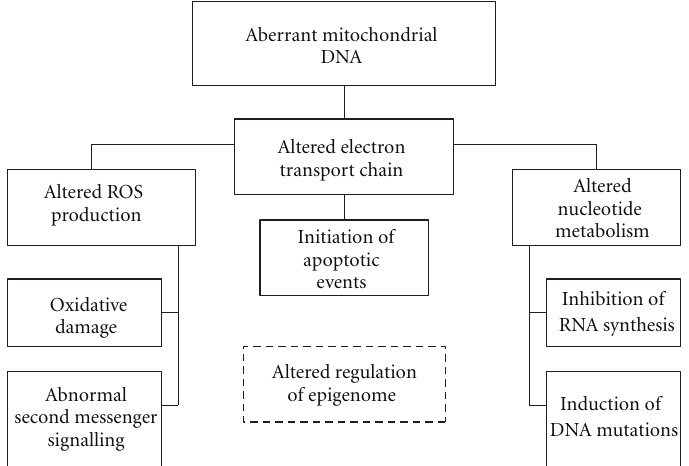
Figure 1: Overview of e ff ects of mtDNA aberrations correlated aging and cancer progression. Aberrant mitochondrial DNA causes a reduced fidelity of the electron transport chain, which in turn can alter the production of reactive oxygen species (ROS), prematurely initiate apoptotic events and alter the nucleotide metabolism. An increased production of ROS can cause oxidative damage to cellular components including nuclear DNA, while both a decrease and increase of ROS can compromise its role as a second messenger molecule, a ff ecting several cellular mechanisms. An altered nucleotide metabolism can result in a altered production of ribonucleotides and deoxyribonucleotides increasing the risk of inhibition of RNA synthesis and DNA mutations, respectively. Aberrant mitochondrial DNA can also alter the regulation of the nuclear epigenome even though the mechanism responsible has not been